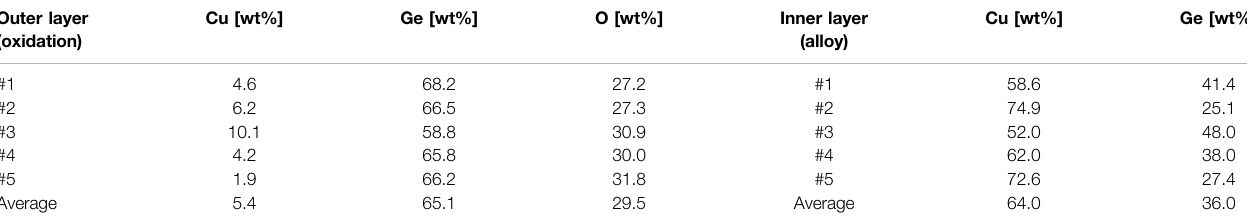
TABLE 3 | EPMA analysis of chemical composition for the oxidized outer layer and the internal microstructure of the alloy. Outer layer